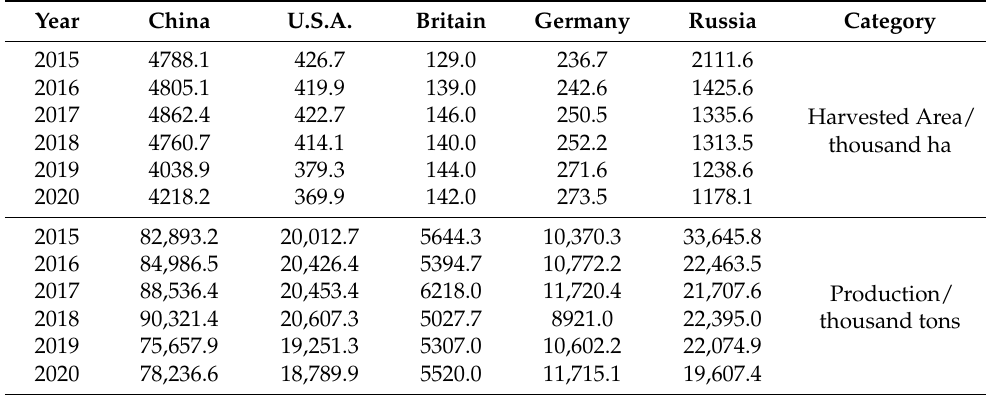
Table 1. Harvested Area /production of potatoes in different countries. Date from reference [8]. Copyright 2022 FAO.